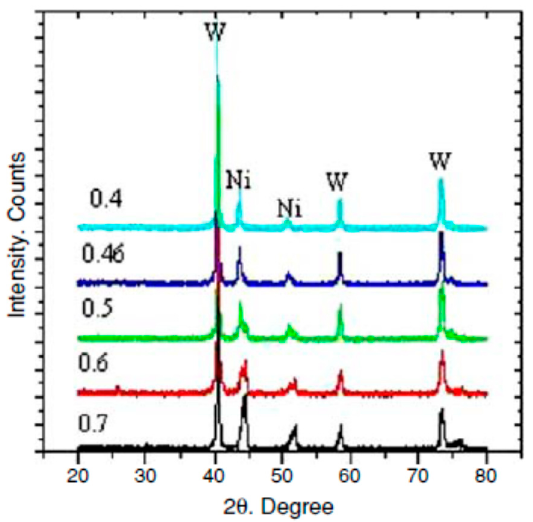
Figure 13. XRD pattern for synthesized Ni-W alloy phases at 1023 K, where 0.7, 0.6, 0.5, 0.46 and 0.4 are Ni/Ni + W molar ratio [10].